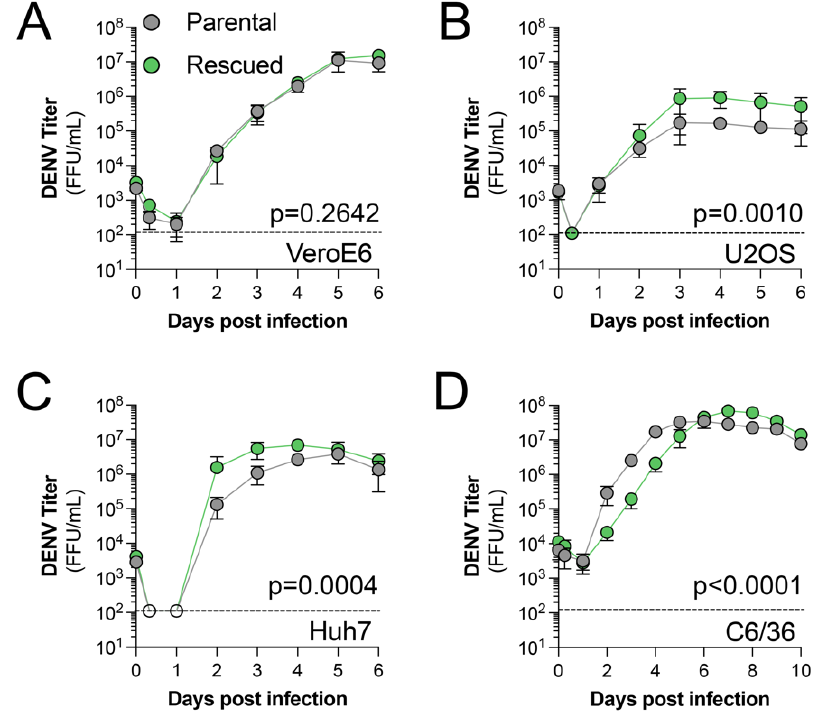
Figure 3. Replication kinetics of rescued virus in commonly used cell lines. ( A – D ) Indicated cell lines were infected with parental or rescued virus at an MOI of 0.01 for the indicated times. Supernatants were collected from the indicated time points and titrated on VeroE6 cells. Data are shown as the average FFU/mL ± SD of three independent experiments. Significance was determined using a 2-way